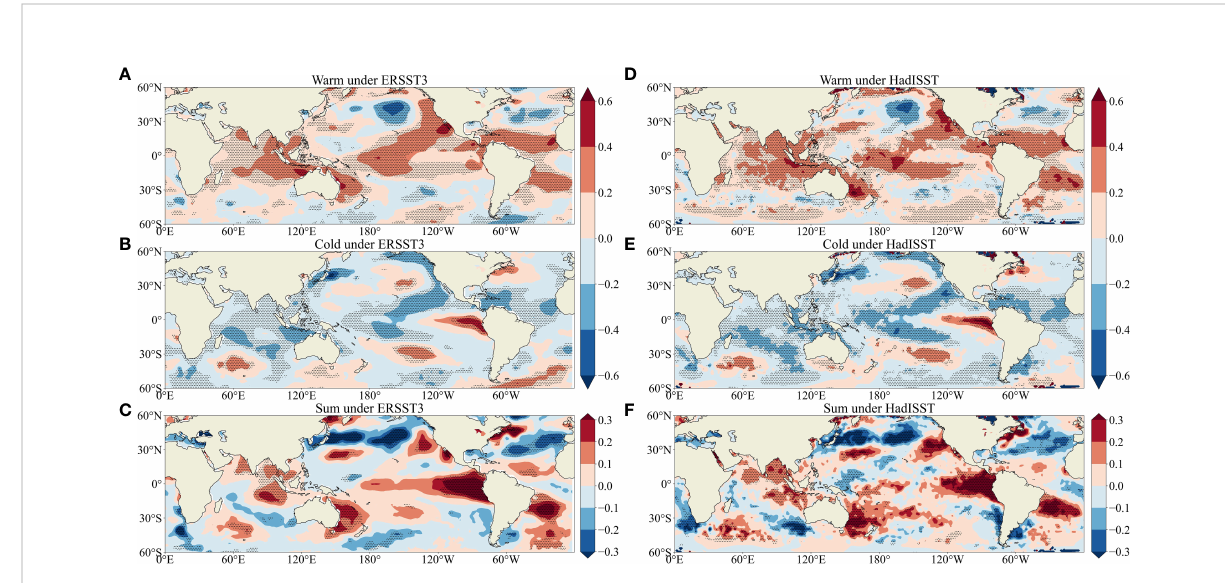
FIGURE 8 Composite SST anomalies for ERSST3 (A) under the IPWP warm and (B) cold events. (C) The summation of the anomalous SST under the IPWP warm and cold phases. Right panel (D – F) , as the left panel (A – C) , but for the HadISST. The dotted represent signi fi cance at the 0.05